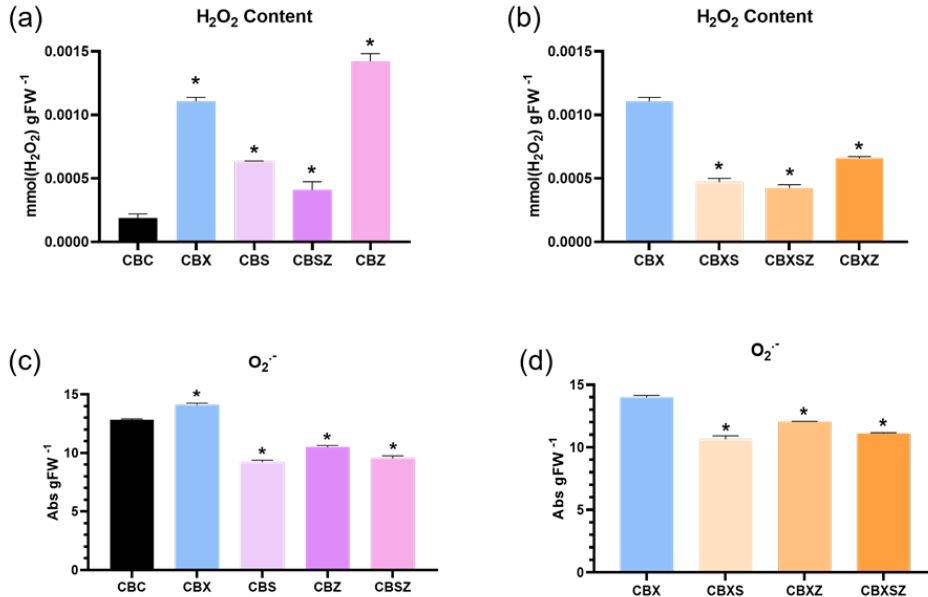
Figure 4. Hydrogen peroxide and superoxide radical content of tomato leaves 12 days after infection and 10 days after treatment application. ( a , c ) represent the levels of uninfected/treated groups (CBS; CBSZ; CBZ) and infected control (CBX) compared to the uninfected control (CBC). ( b , d ) represent the levels on infected/treated (CBXS; CBXSZ; CBXZ) groups compared to the infected/untreated control (CBX). Values are presented as mean ± standard deviation (n = 3). Means marked with an asterisk are statistically different from the respective control group according to the Dunnett comparison test ( p < 0.05).